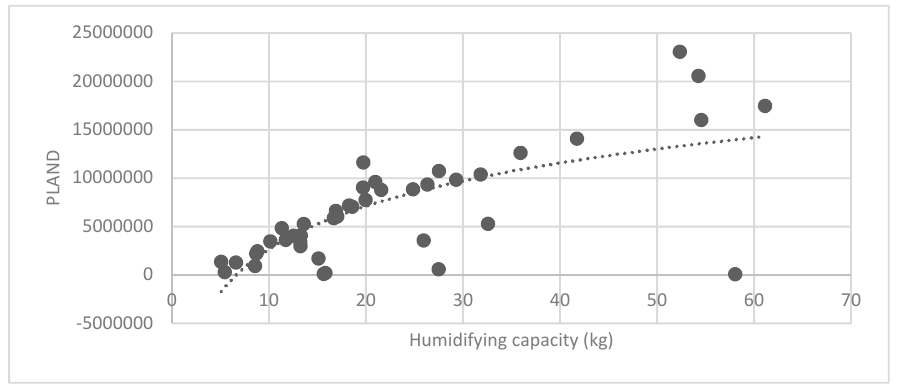
Figure 14. Association between forest land PLAND index and humidifying capacity.